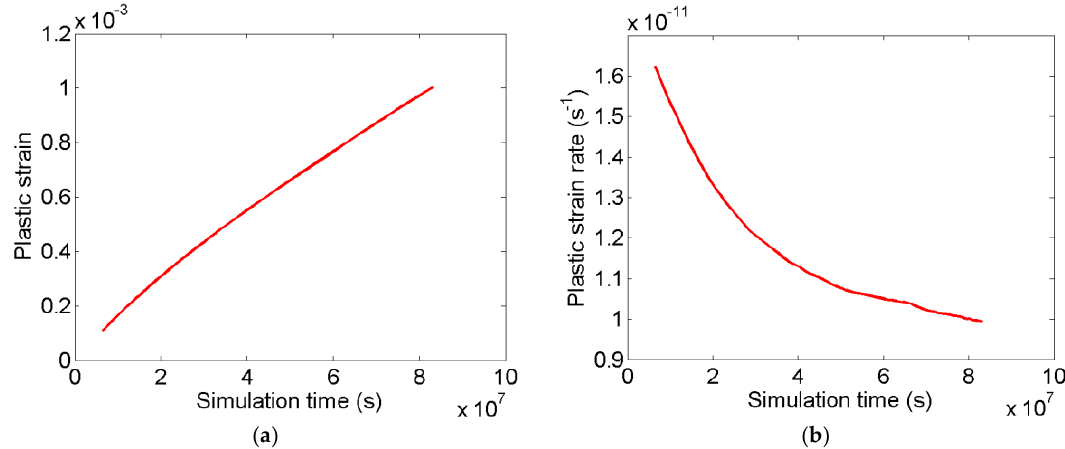
Figure 4. ( a ) Plastic strain and ( b ) plastic strain rate versus simulation time for deformation with the original mobility value M glide = 2.89 × 10 −13 (Pa·s) −1 .